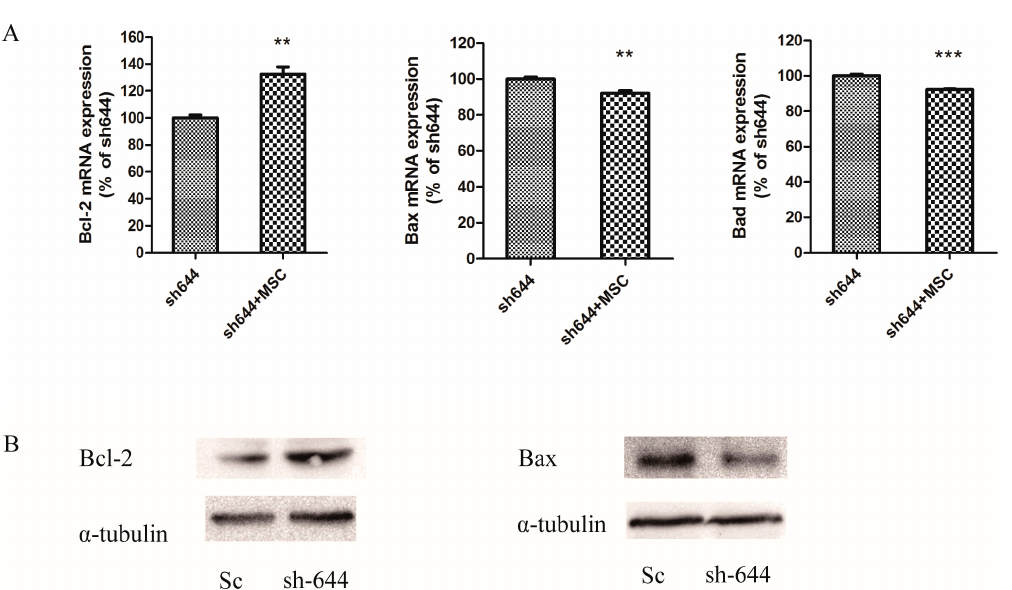
Figure 6. Altered expression levels of apoptosis-related genes Bax , Bcl-2 and Bad in the Clu -knockdown N2a cells treated with 1 μ M MSC. Cells transfected with the plasmid pGPU- Clu -mus-sh644 (sh644) were used as the control. ( A ) Real-time PCR detection of Bax , Bcl-2 and Bad mRNA expression; ( B ) Western blot analyses of Bax and Bcl-2 protein expression. ** p < 0.01 and *** p < 0.001 vs. the